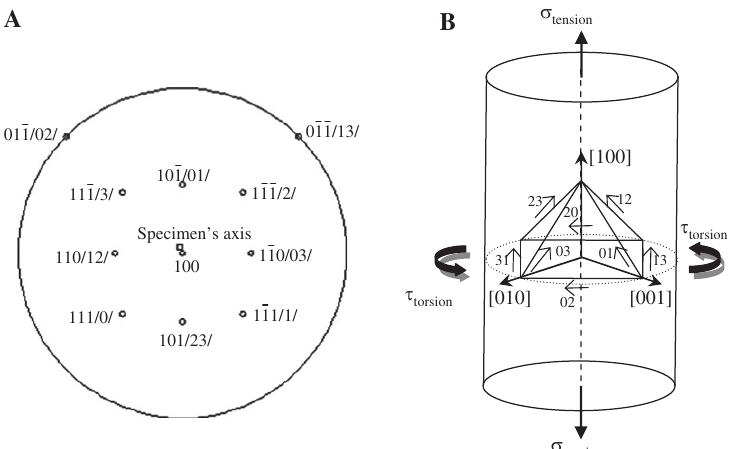
Figure 1 (A) Stereographic projection of the axis of the < 100 > single crystals used. The numbers 0, 1, 2, and 3 between slashes represent the slip planes (111), ( 111 ), ( 111 ), and ( 111 ), respectively. Slip directions α β (with α ≠ β and α β = β α ) are also shown between slashes. (B) Schematic representation of the slip systems in a cylindrical specimen of a perfect < 100 > single crystal.